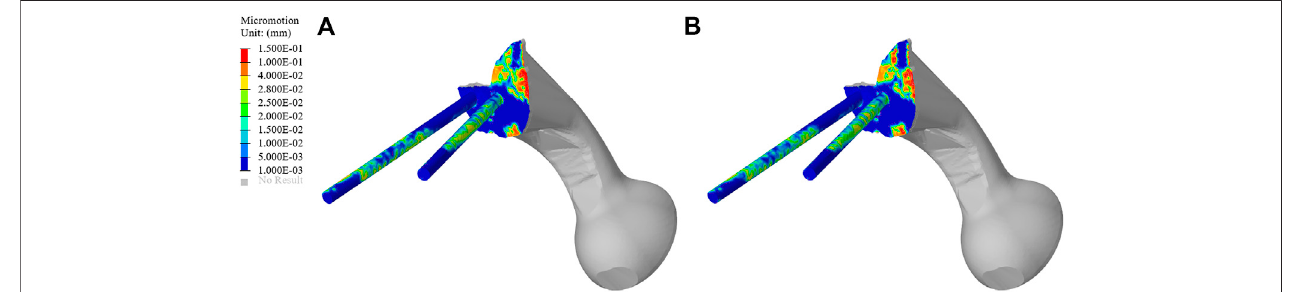
FIGURE 10 | Micromotion results of TO prosthesis. (A) Original prosthesis, (B) TO